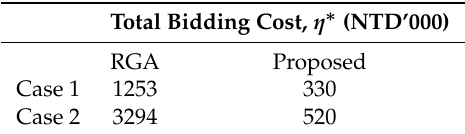
Table 4. Comparison of the total bidding cost produced by all compared